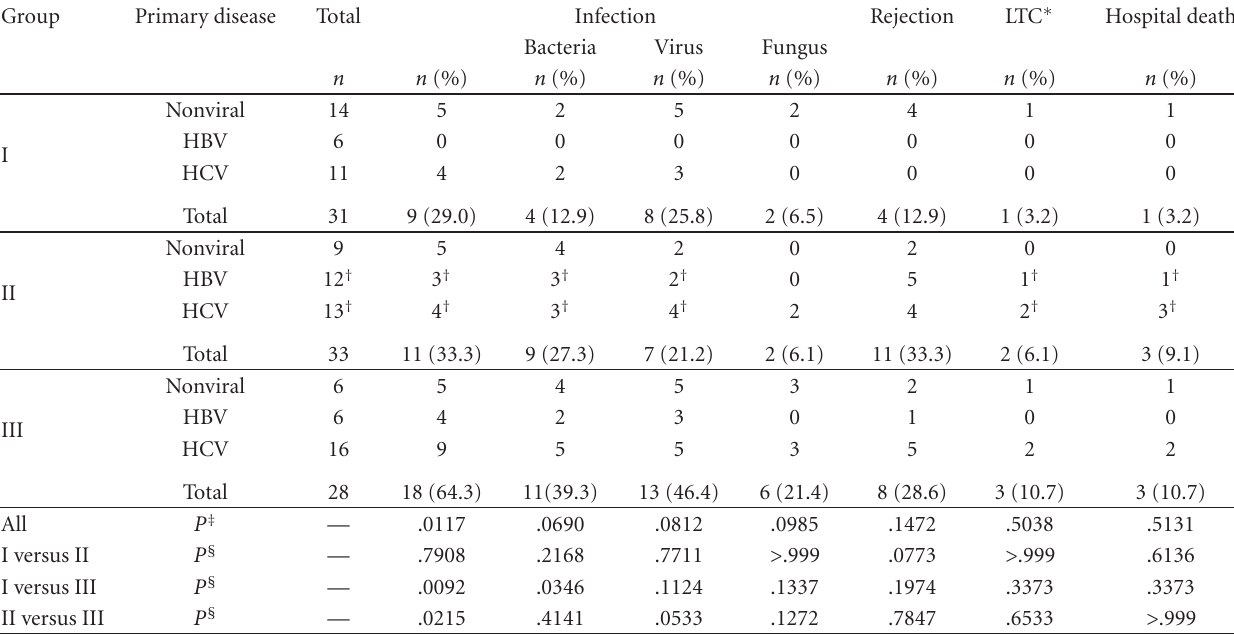
Figure 3: Changes in % di ff erence in CD8 + naive, CM, EM, and e ff ector T cells after LDLT in a 55-year-old female recipient. Right, scatter plot between % E di ff erence and % e ff ector T cell proportion. A, period associated with acute cellular rejection, infection and liver damage. B, period associated with acute cellular rejection and aspartate aminotransferase elevation. C, aspartate aminotransferase elevation. White circles denote naive (N), black circles denote e ff ector (E), white triangles denote central memory (CM), black triangles denote e ff ector memory (EM), Pre, pre-LDLT; CsA, cyclosporine A; Tac, tacrolimus; the number below black circles in right figure, postoperative days. Table 2: Frequencies of Posttransplant Infection, Complication and Mortality in 3